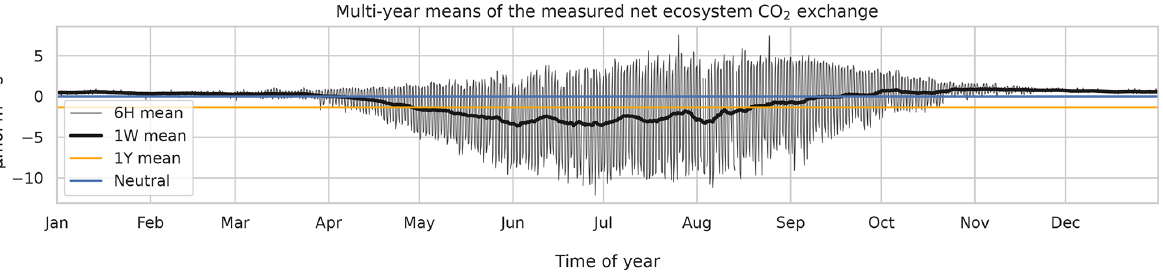
Figure 1. The 6h (thin black), weekly (thick black), and annual (orange) multi-year means of observed net ecosystem CO 2 exchange (NEE) at the Hyytiälä SMEARII site. Eddy covariance method with a 24m tall tower was used for measurements. Years 1996–2018 were used in calculation of the mean values.